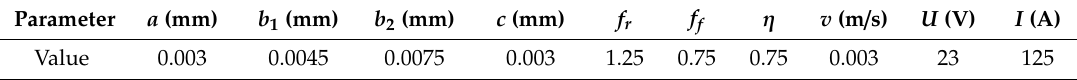
Table 7. Parameter values of the Gaussian heat source.